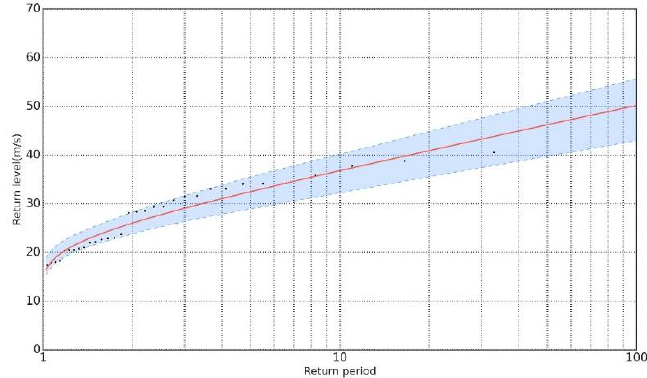
Figure 21. Regression curve of the wind speed at the Xisha Islands using the AM-GEV method.